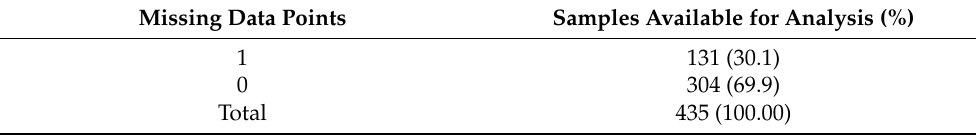
Table 1. Missing data distribution.